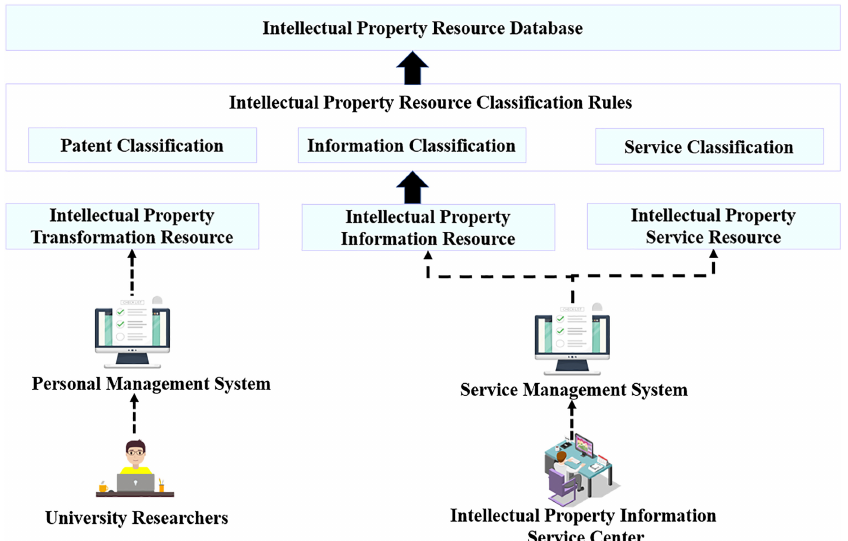
Figure 2. Function design of